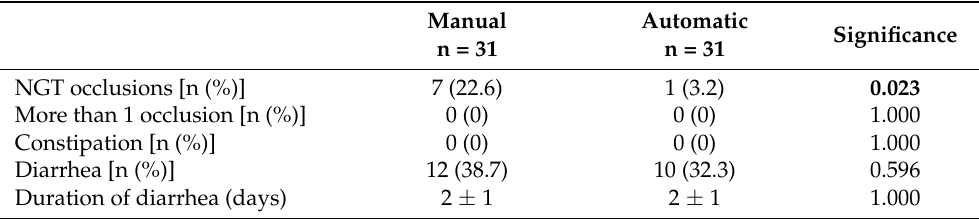
Table 2. Gastrointestinal symptoms of the included acute-stroke patients (n = 62) in the manual and automatic flush pump groups. Means ± standard deviations and